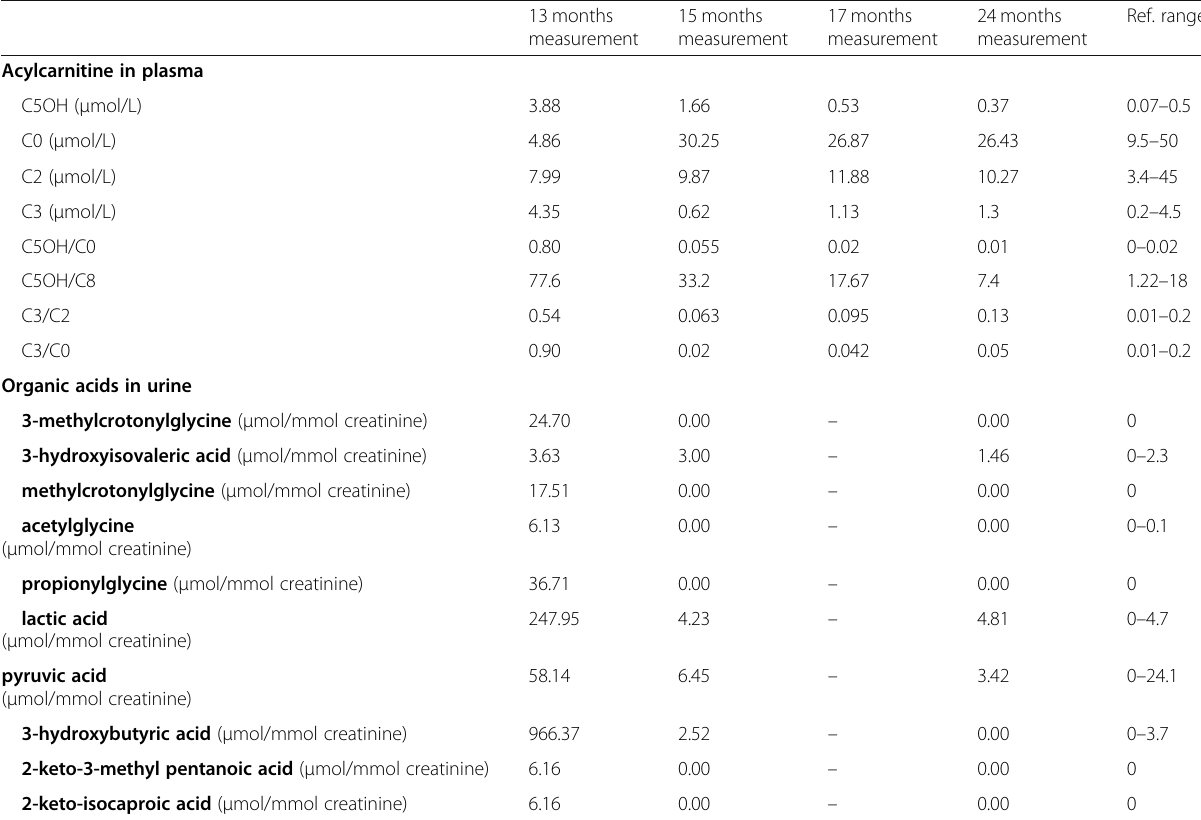
Table 1 Metabolites in plasma and